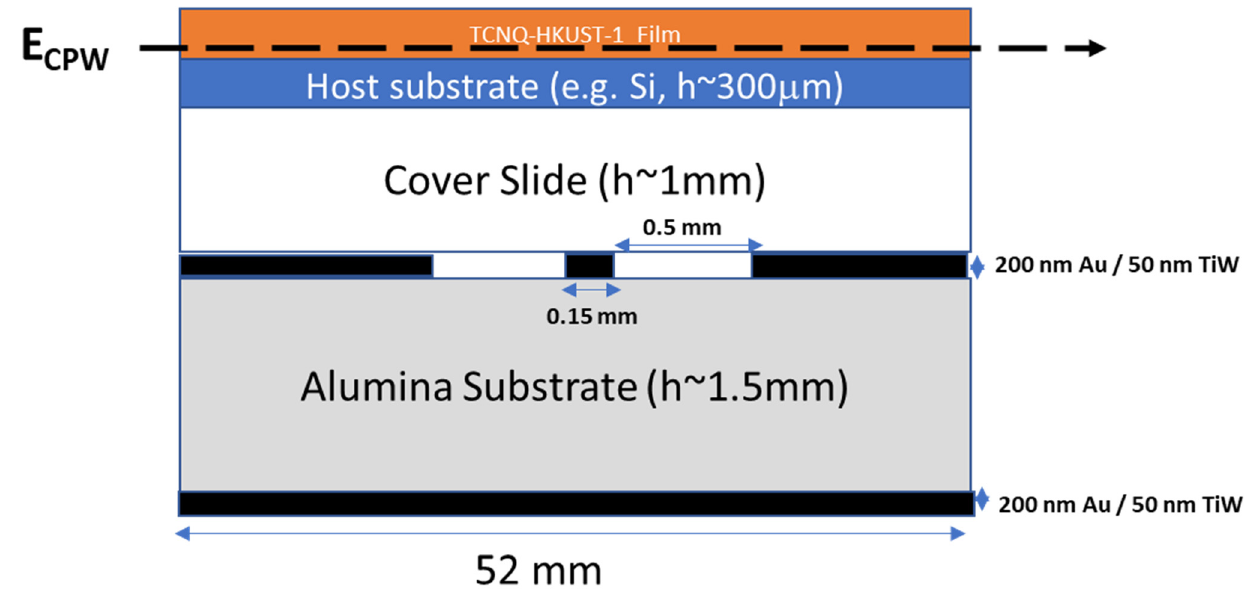
Figure 1. A phenomenological model of a doped HKUST-1 SURMOF under microwave interrogation in a gaseous ambient. E CPW is an electric field fringe from the microwave emanating from the signal line and terminating on the ground line of the GSG CPW. Note that the figure is for illustration only, and not to scale. Some features important features have been deliberately exaggerated for illustrative purposes.